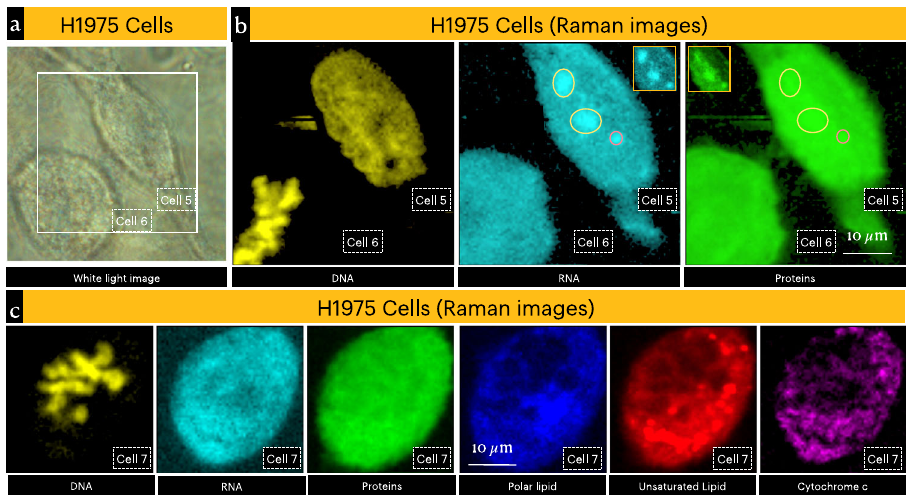
Fig. 3 Raman images of mitotic cells. a White light image of elongated and circular H1975 cells, and b the corresponding Raman images of DNA, RNA, and proteins ( see also Fig. S11). Nucleoli and Cajal body are marked with yellow and red circles, respectively. Inset shows better contrast Raman images of nucleoli and Cajal body from cell 5. Condensed chromosome (DNA) in circular cell (cell 6) indicates that they are in the metaphase of mitotic cell division. LLPS domains are absent in cell 6. c Raman images from another circular cell in the metaphase of mitotic cell division. LLPS organelles are also absent in the cell